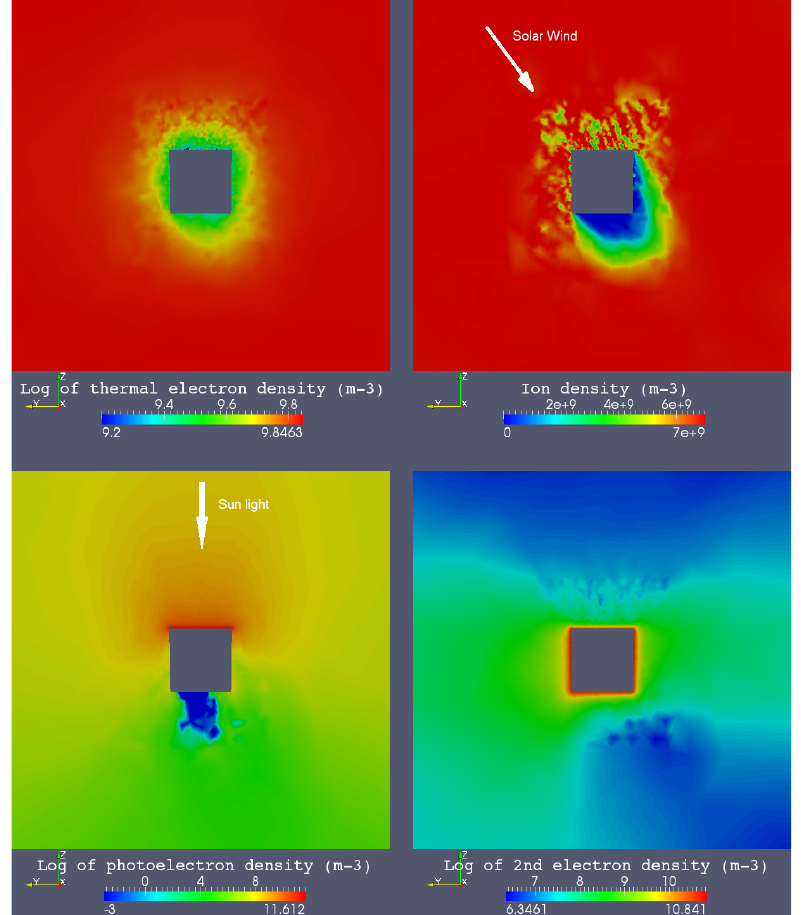
Fig. 18. Simulation S5 population density maps: (a–d) from the upper left figure to the lower right figure. (a) Thermal electrons, (b) Ions, (c) Photoelectrons, (d) Secondary